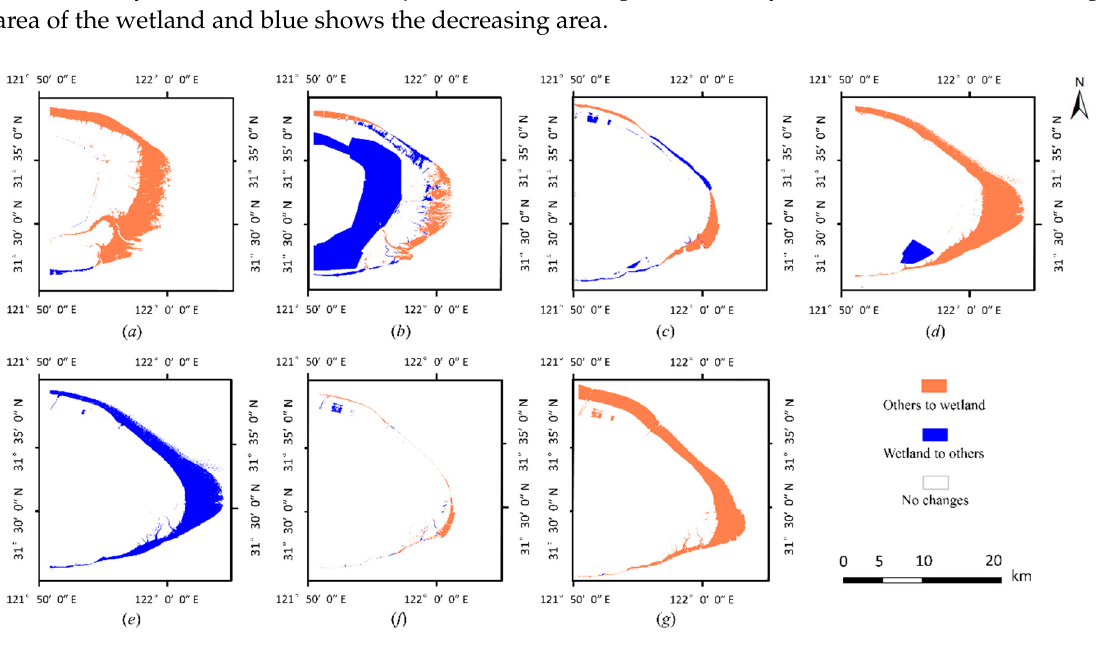
Figure 6. Change detection result of wetland from 1986 to 2013: ( a ) 1986–1990; ( b ) 1990–1995; ( c ) 1995–2000; ( d ) 2000–2003; ( e ) 2003–2007; ( f ) 2007–2009; and ( g ) 2009–2013.